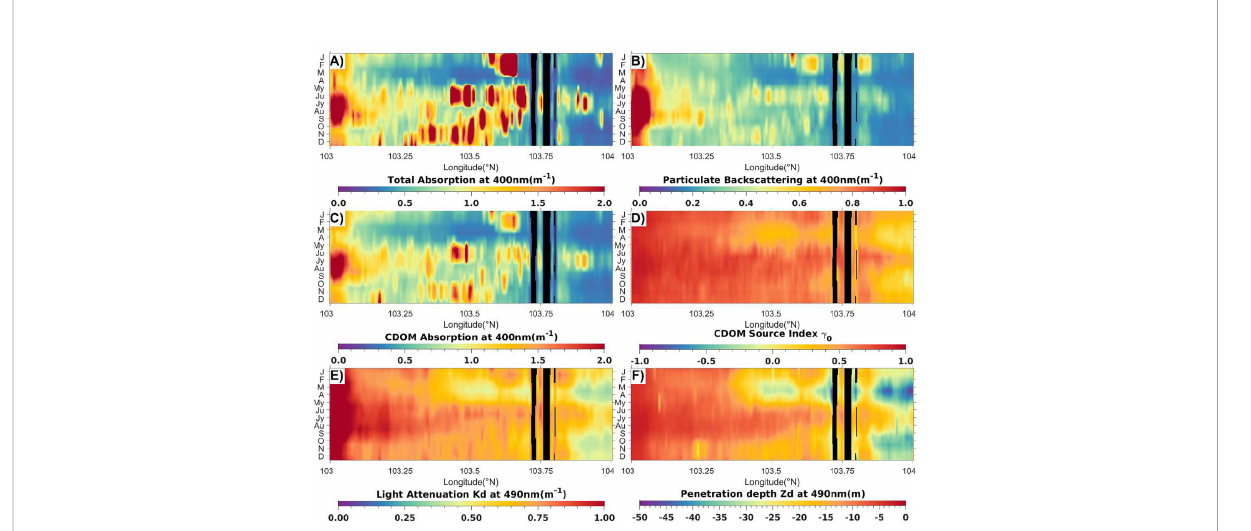
FIGURE 6 Transect from Sumatran coastal waters to Singapore Strait (latitude=1.24°CN) for monthly averaged (2017-2020) optical properties (A) Total absorption coef fi cient of light (a t ) at 400 nm. (B) Particulate backscattering (b bp ) at 400nm. (C) CDOM absorption coef fi cient (a g ) at 400 nm. (D) CDOM source index, g 0. (E) Diffuse attenuation coef fi cient of light (K d ) at 490 nm. (F) Depth of maximum penetration of light at 490 nm (Z d , 1% of the surface value). The fi gure displays the transport of organic matter rich and sediment-laden waters from the Sumatran coast to Singapore Strait during the Southwest monsoon